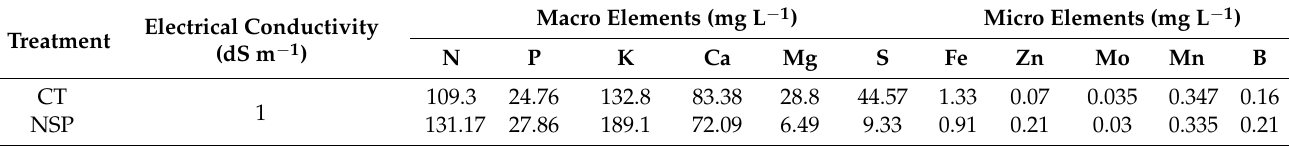
Table 1. The greenhouse nutrient solution (CT) and newly-developed nutrient solution for red perilla (NSP). Electrical Conductivity Treatment